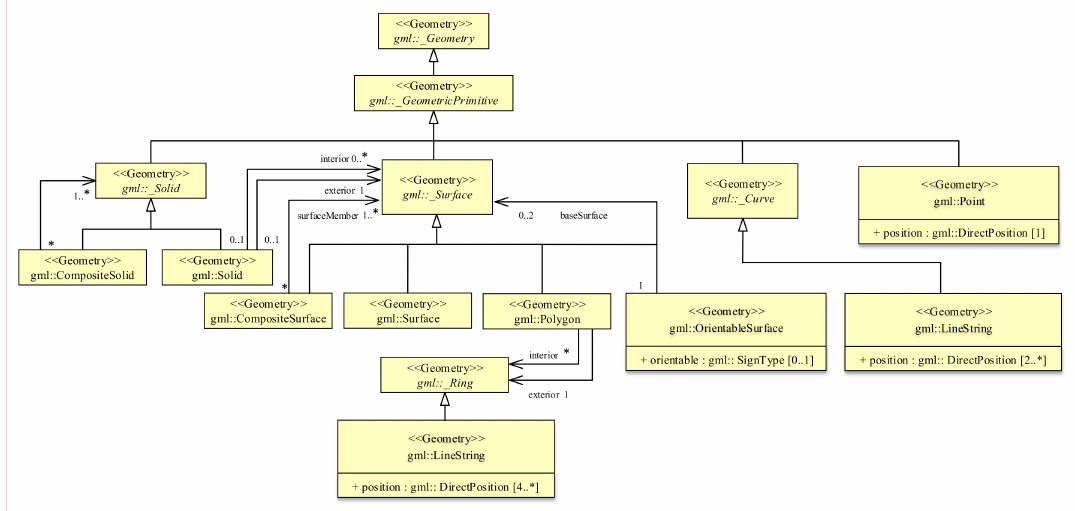
Figure 5. UML diagram of adapted 3D indoor spatial geometry model based on